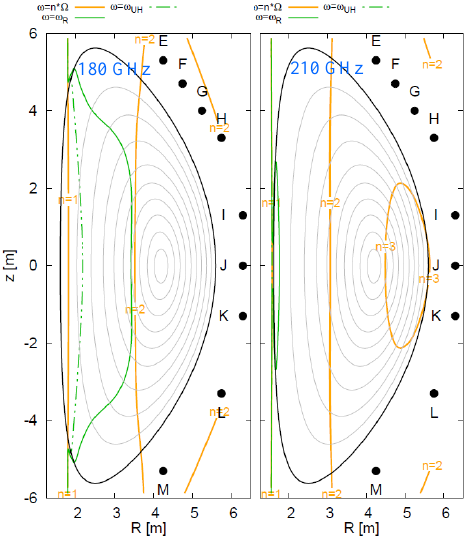
Fig. 1 : The plasma equilibrium and candidate launch locations for the SPR-045 concept. Harmonics, X-mode cut-off and upper hybrid resonance are shown for 180 GHz (left) and 210 GHz (right)